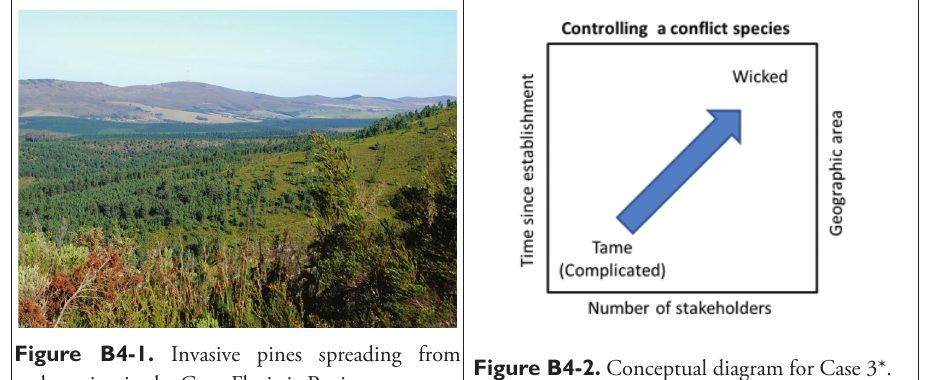
Figure B4-2. Conceptual diagram for Case